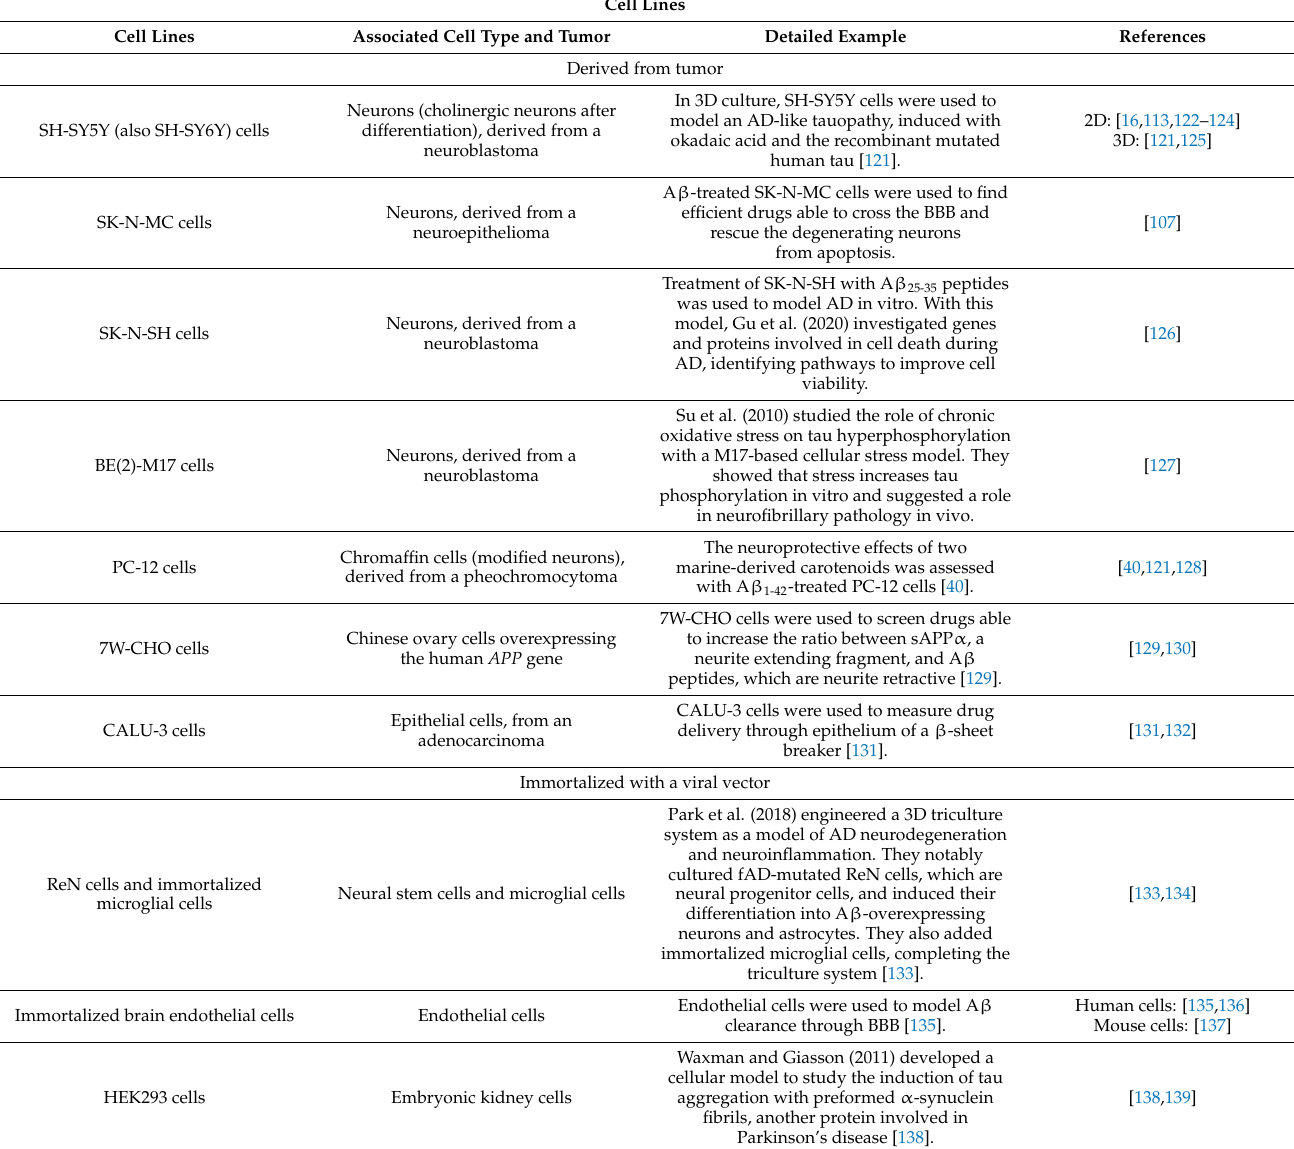
Table 3. Examples of key data obtained from AD cell line